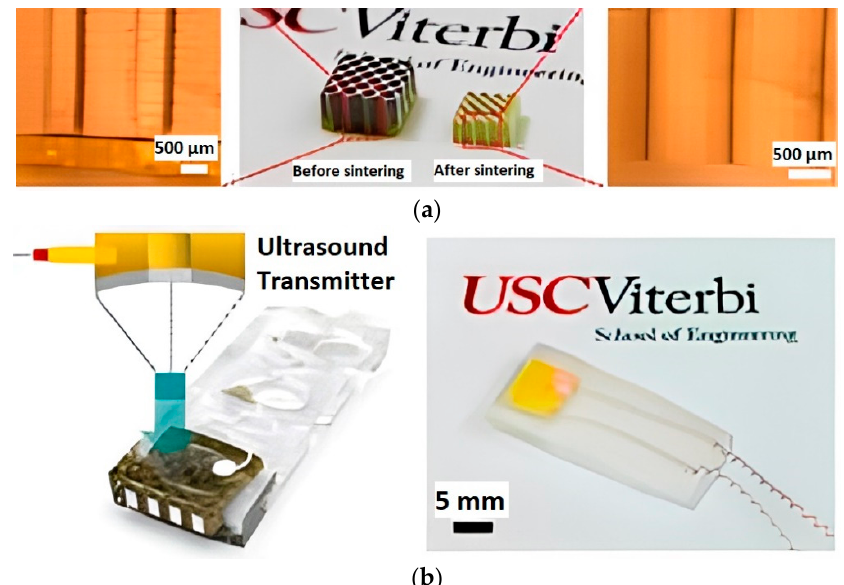
Figure 10. ( a ) The 3D-printed honeycomb structure of FGP before (left) and after (right) sintering; ( b ) Schematic and design of the ultrasonic device (left) and fabricated device (right) (available under Creative Commons license [80]).